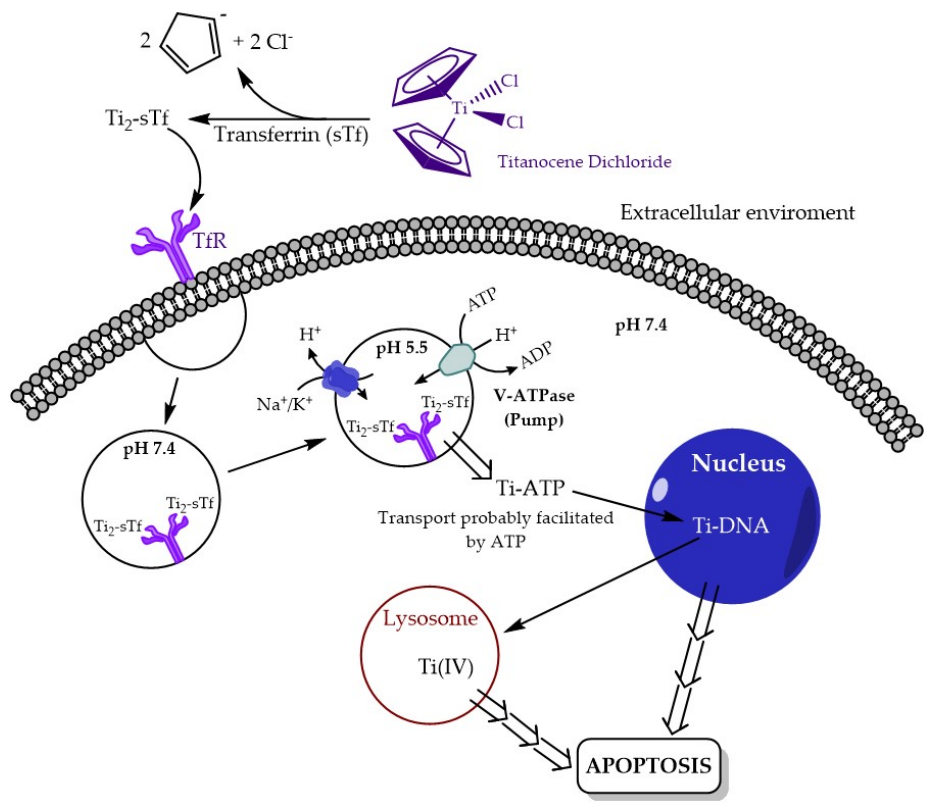
Figure 5. Proposed cytotoxic mechanism of action of Cp 2 TiCl 2 .